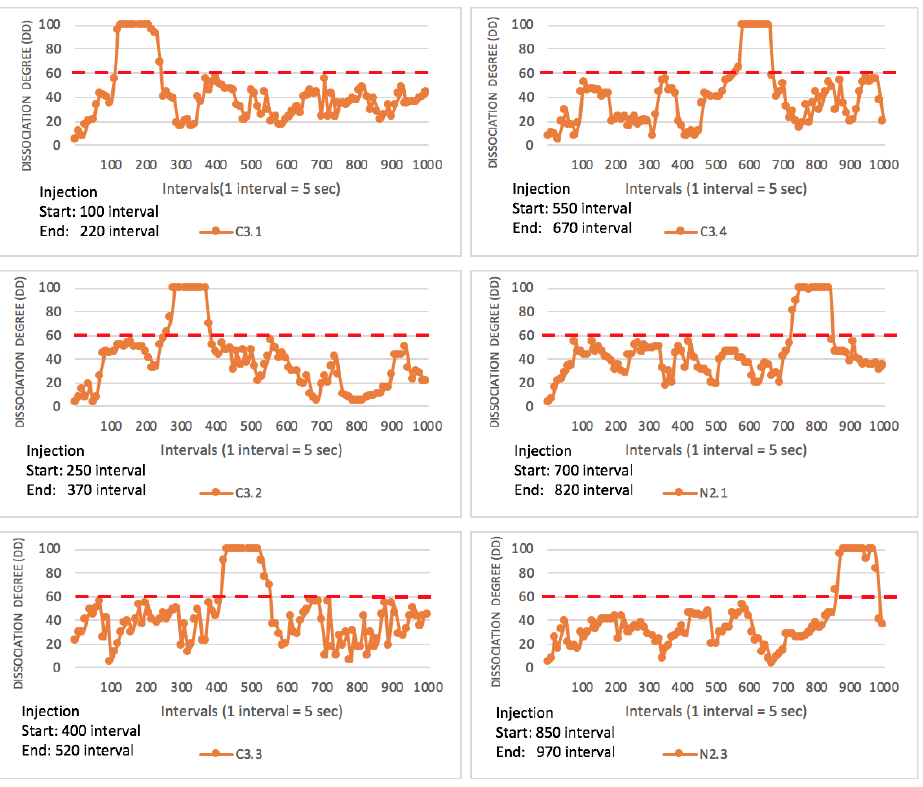
Figure 5. CPU hog detection using HHMM for components.